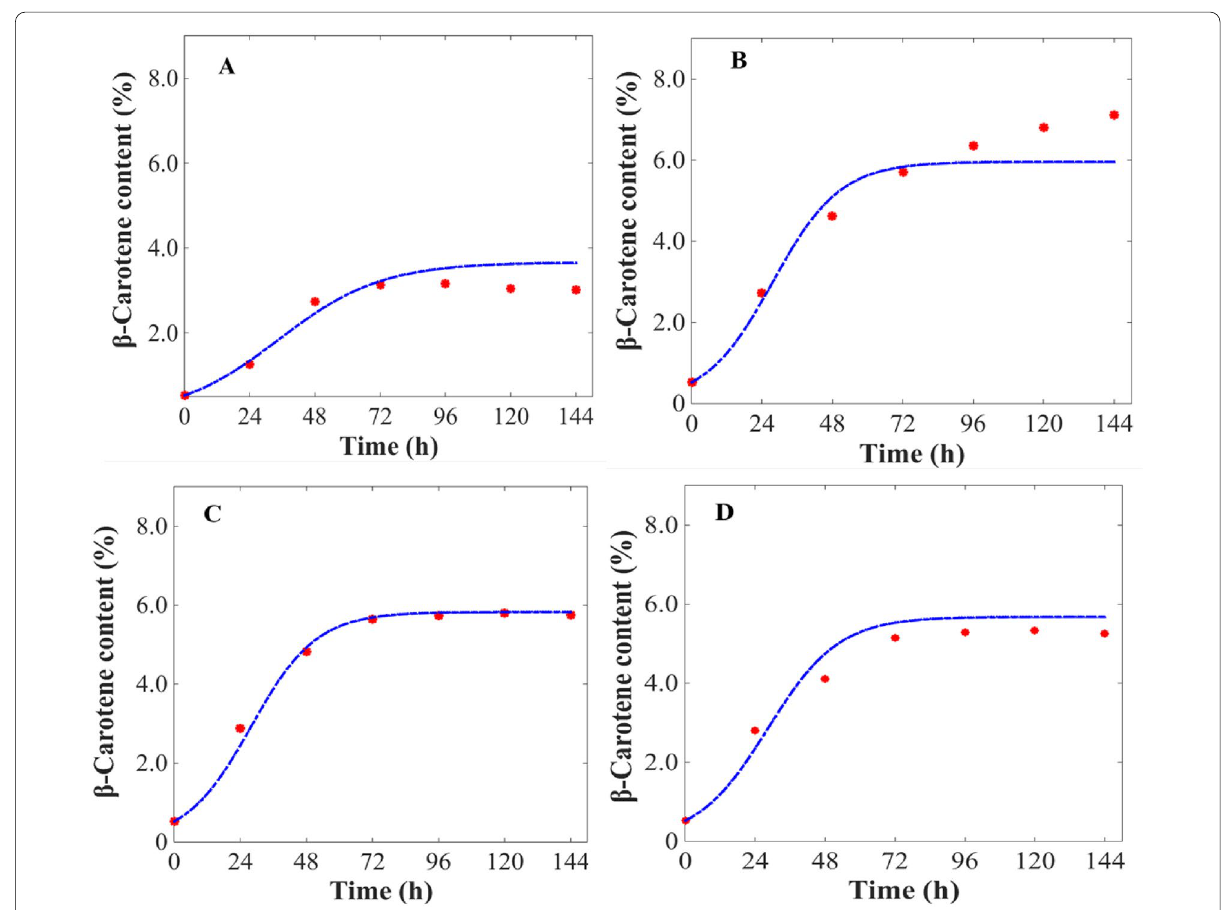
Fig. 6 Comparison of model simulation results and real experimental data of β-carotene content in D. salina . A–D were the arbitrary cultivation condition parameter values showed in Table 3, and the initial dry weight was 0.1 g the temperature was 20, 25, 20, and 25 ℃ , light intensities were 200, 600, 800, and 1000 μmol 5, 5, 200, and 200 mM; and the nitrogen concentration was 50, 500, 50, and 500 mg points indicate experimental